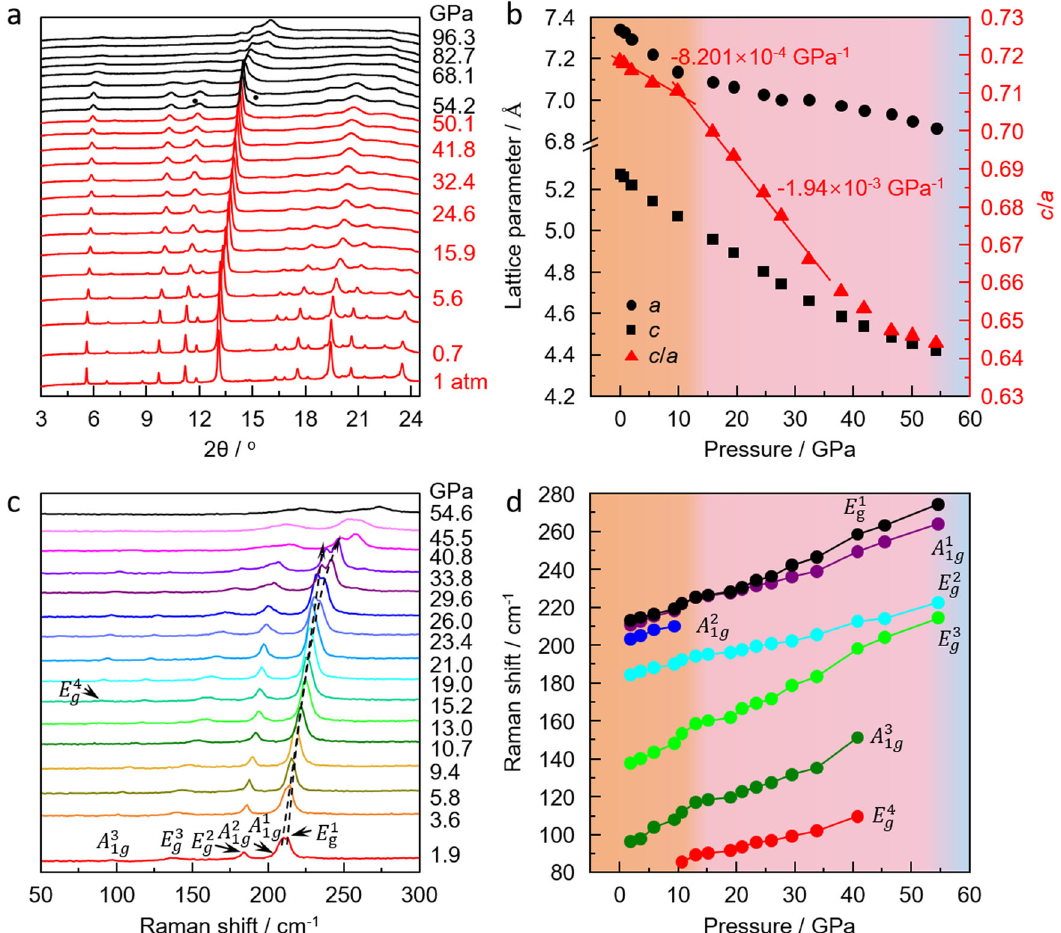
Fig. 3 Structure evolution of Pt 2 HgSe 3 under high pressure. a XRD patterns of Pt 2 HgSe 3 under pressure up to 96.3 GPa at room temperature with an x-ray wavelength of λ = 0.6199 Å. The red and black patterns distinguish phase transition with pressure over 50.1 GPa. The new peaks attributed to phase II are marked with black dots. b Pressure dependence of lattice parameter a , c , and c/a ratio for Pt 2 HgSe 3 P 3 m 1 phase. c Raman spectra at various pressures for Pt 2 HgSe 3 . d Raman shift for Pt 2 HgSe 3 in compression; the vibration modes display in increasing wavenumber